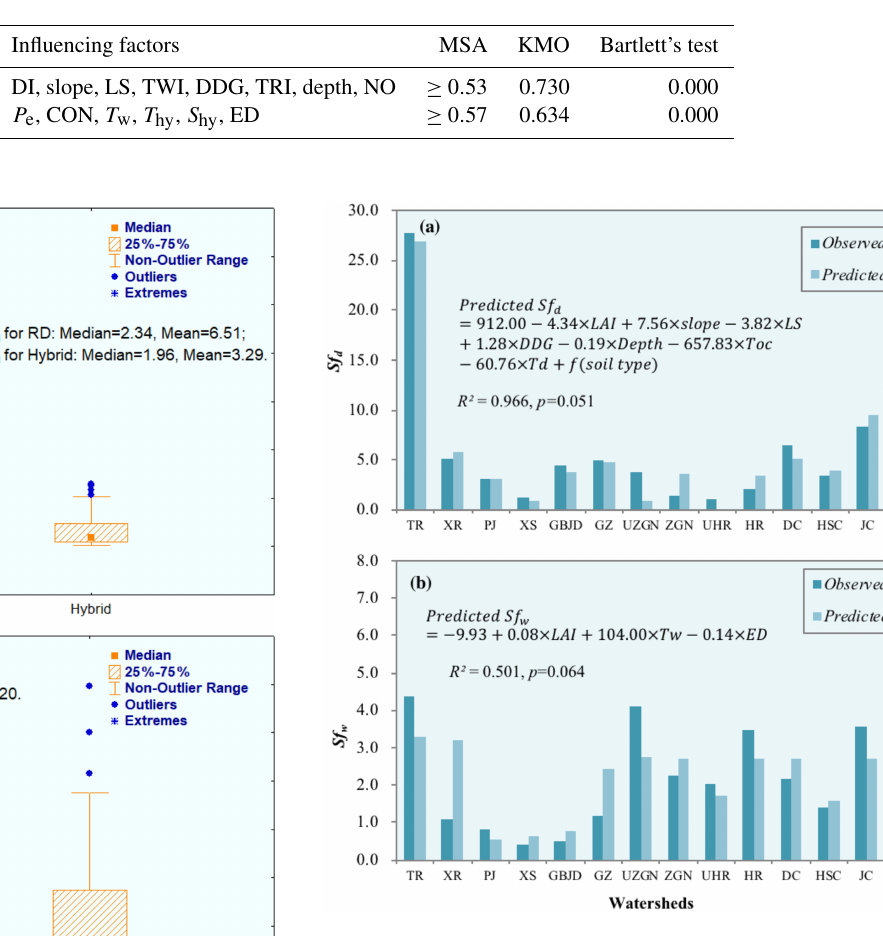
Figure 6. Comparisons of observed and predicted ecohydrological sensitivity in the (a) dry season and (b) wet season (TR, XR, PJ, XS, GBJD, GZ, UZGN, ZGN, UHR, HR, DC, HSC, JC and RR refer to the Tangwang River, Xinancha River, Pingjiang, Xiangshui, Gong- bujiangda, Gengzhang, Upper Zagunao, Zagunao, Upper Heishui River, Heishui River, Dongchuan, Heishuichuan, Jingchuan and Rui River watersheds,